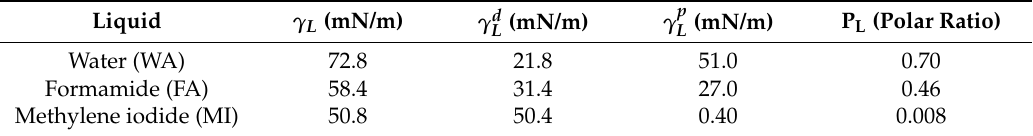
Table 3. Reference values of surface energy components of liquids [49].